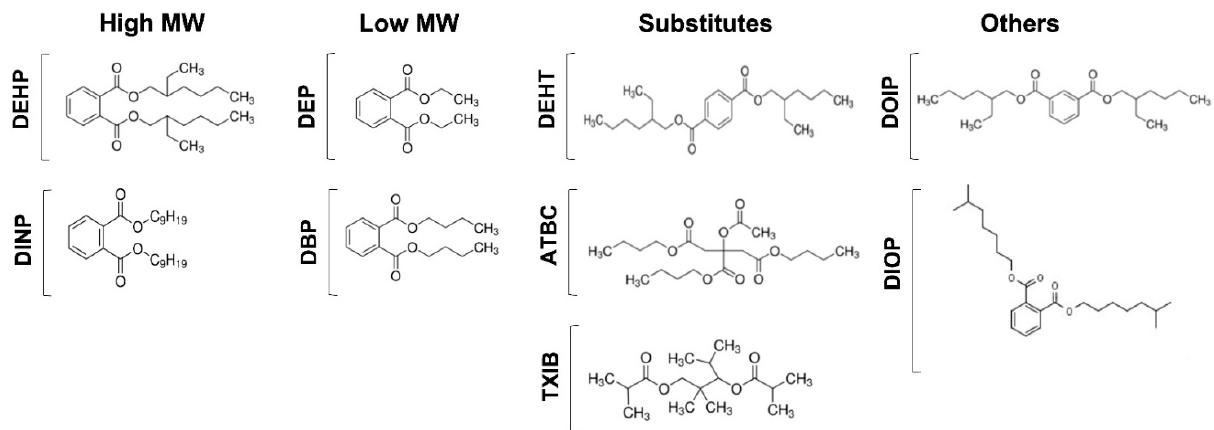
Figure 1. Phthalates and substitutes used in this study. High molecular weight phthalates: DEHP (2-éthylhexyl)-phthalate), DINP (bis (7-methyloctyl) phthalate). Low molecular weight phthalates: DEP (diethyl phthalate), and DBP (dibutyl phthalate). Substitutes: DEHT (bis (2-ethylhexyl) tereph- thalate), ATBC (tributyl acetylcitrate), and TXIB (2,2,4-trimethyl-1,3-pentanediol diisobutyrate). Other substitutes: DOIP (di-2-ethylhexyl isophthalate) and DIOP (dicyclohexylphthalate).